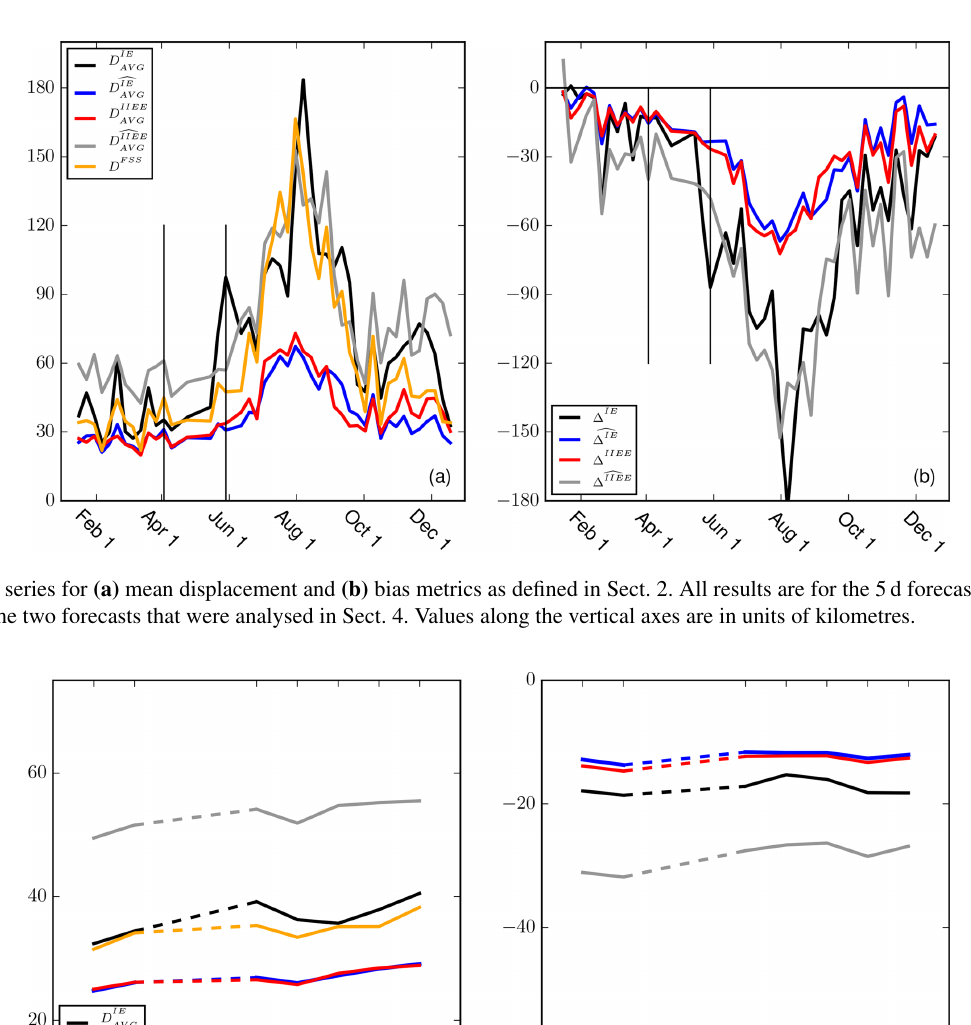
(cid:92) D IE and D IIEE in (a) nearly overlap, as do lines for d (cid:49) IE and (cid:49) IIEE in AVG AVG